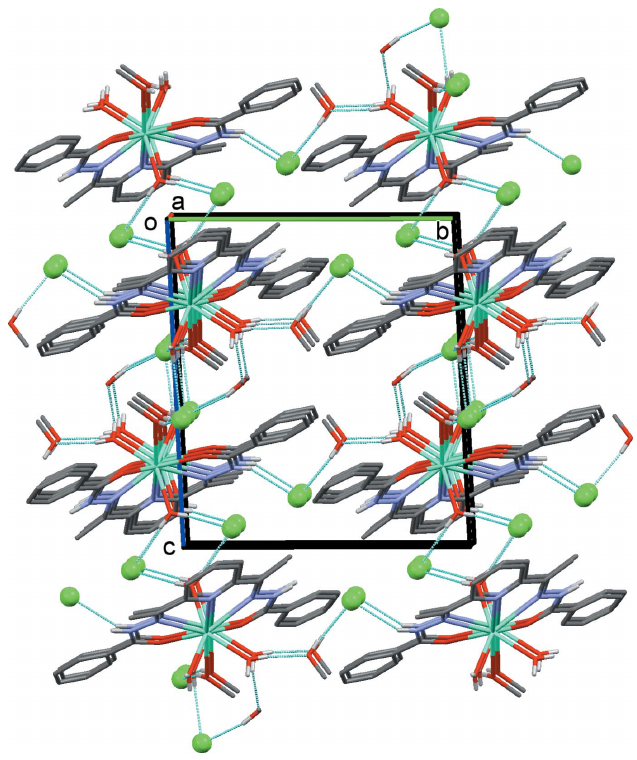
Figure 3 A view along the a axis of the hydrogen-bonded (dashed lines) supramolecular framework of the Tb III complex. The Cl (cid:5) ions are shown as green balls and the C-bound H atoms have been omitted for clarity.